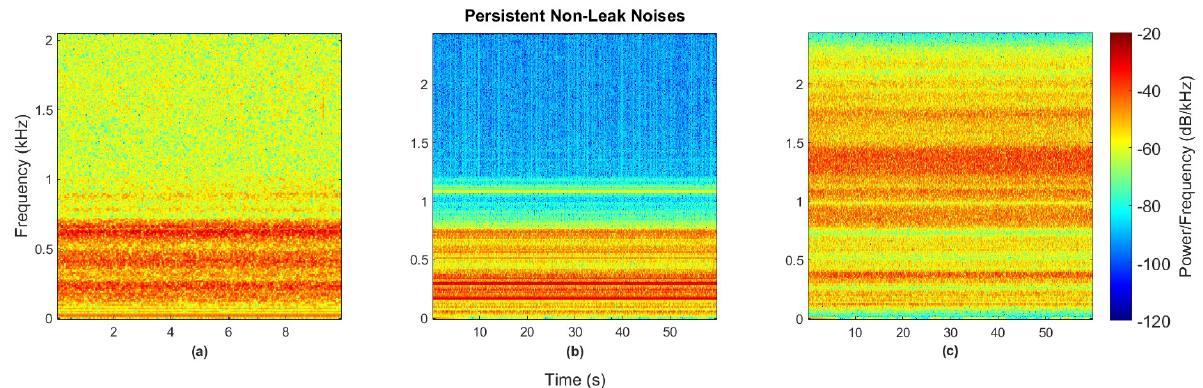
Figure 5. Spectrograms of audio files removed from the data sets, due to loggers in close proximity to water induced noises similar to leak noises. Persistent non-leak noises are from a: ( a ) DV breach; ( b ) pumping station; ( c )